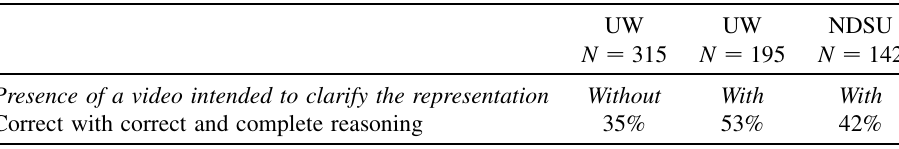
TABLE VII. Percentage of correct answers with correct reasoning on the slit separation task before any instruction on two-source interference and either with or without a video intended to help students interpret the